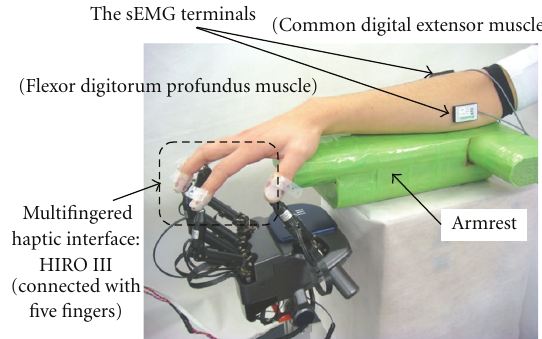
Figure 6: Experimental appearance. The subject can use the armrest for rejecting the e ff ect on the sEMG from certain muscles that relate to wrist movement. Since the proposed system is focused on fingertip movement, in order not to move the wrist, the subject puts the palm on the